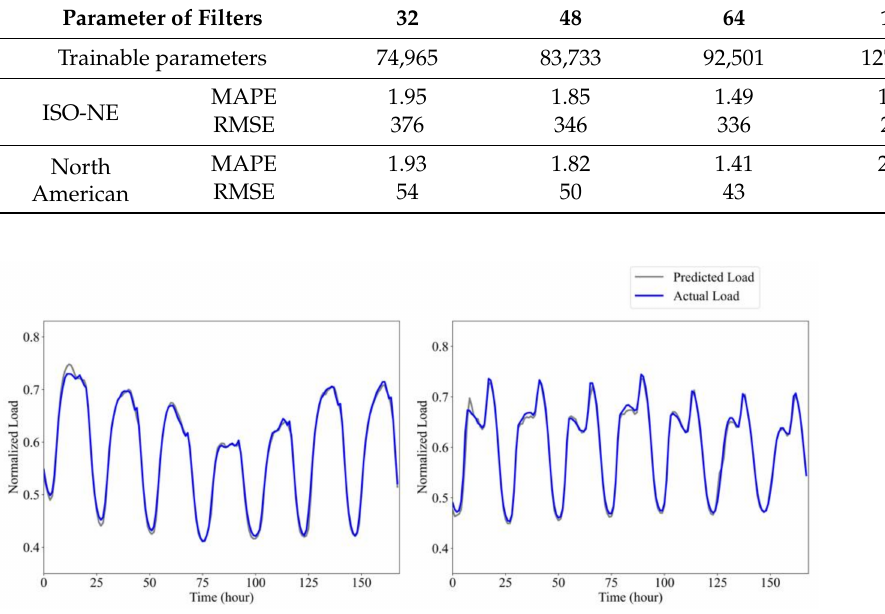
Figure 7. Actual and predicted load for a summer week ( left ) and a winter week ( right ) of 2014 for the ISO-NE dataset; 12 August 2014 and 12 January 2014 begin the separate two-week